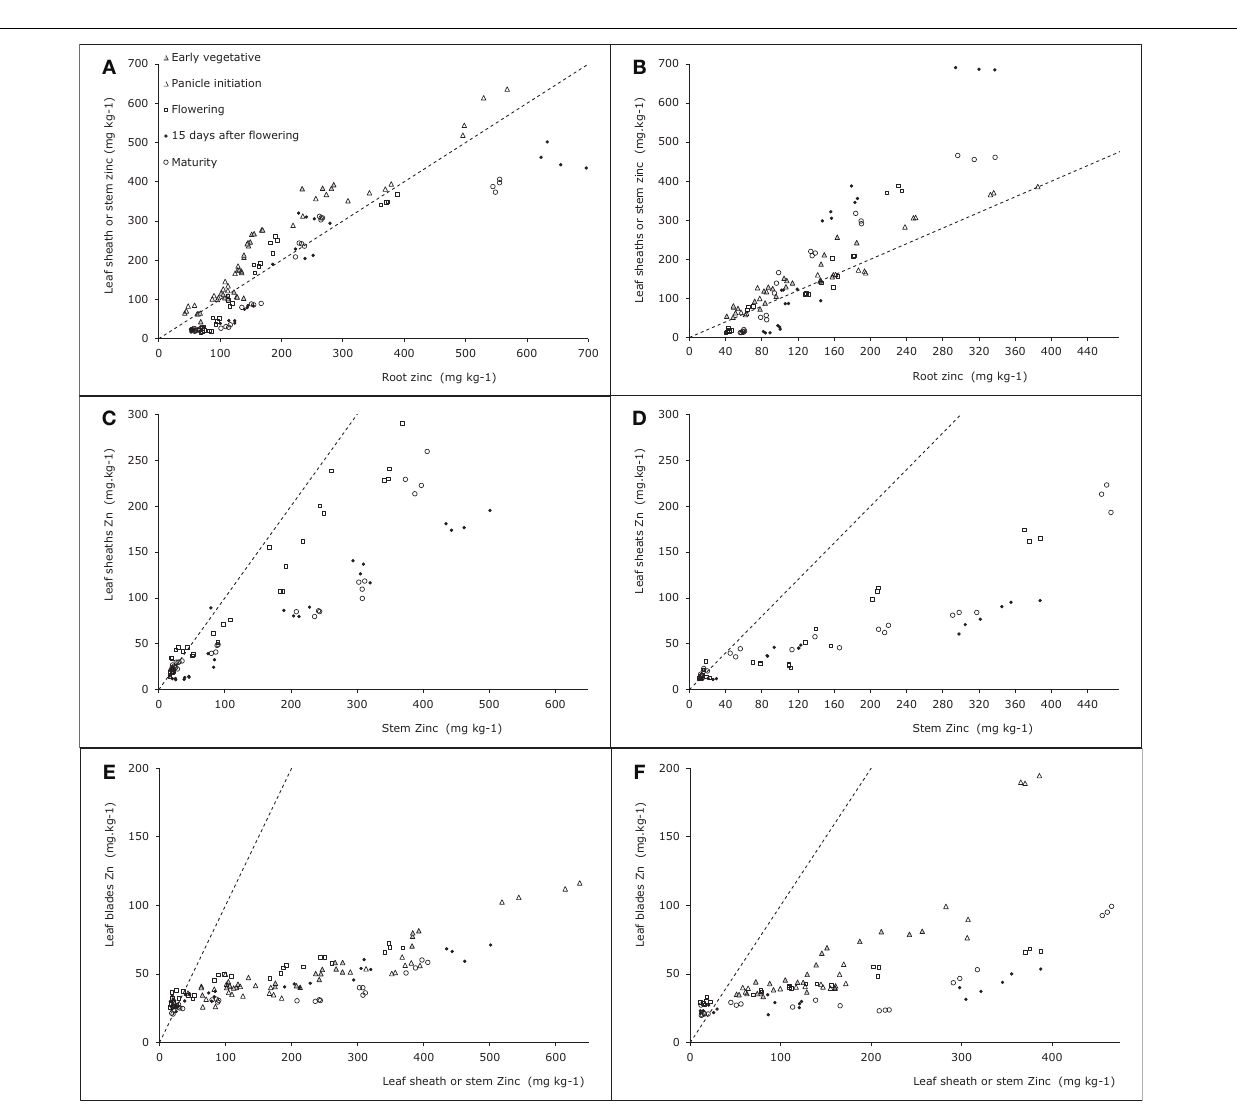
and open triangles, open squares, black dots, and open circles represent plants during early vegetative growth, panicle initiation, flowering, mid grain filling, and grain maturity respectively, the broken lines indicate the 1:1 line in each